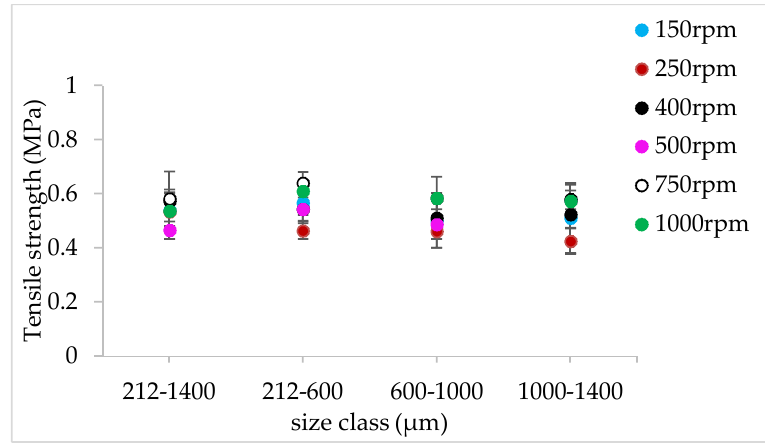
Figure 11. Tensile strength of tablets of lactose granules produced at varying screw speed at SFL—0.083 and PFN—3.42806 × 10 −5 (L/S 0.048).